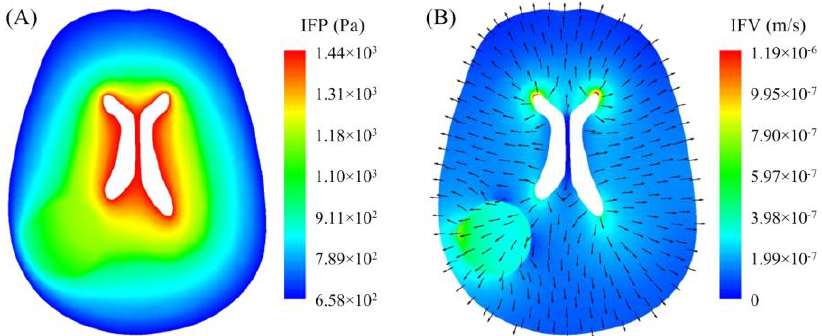
Figure 4. Predicted ( A ) interstitial fluid pressure and ( B ) velocity in the brain. Results are shown on a cross-section that covers regions of brain tumour, normal brain tissue and ventricle. Table 3. Predicted interstitial fluid flow.